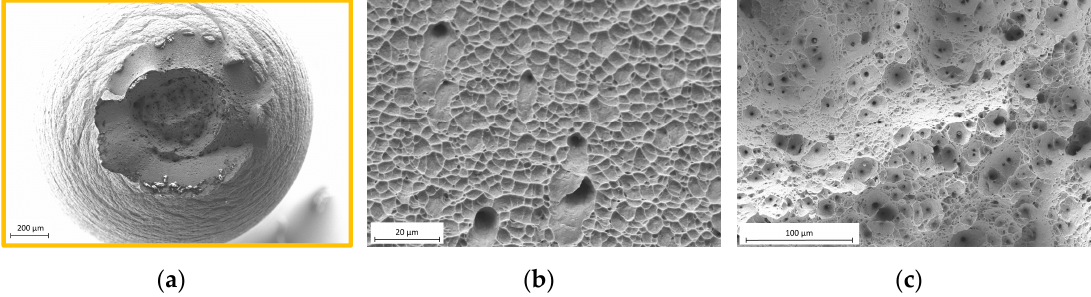
Figure 9. Fracture surface of the SSRT in 5 wt.% NaCl buffered to pH 3.5 at 80 °C: ( a ) pure ductile fracture surface without visible cracking, ( b ) ductile structure at the edge of the sample, ( c ) ductile dimples in the centre of the sample.